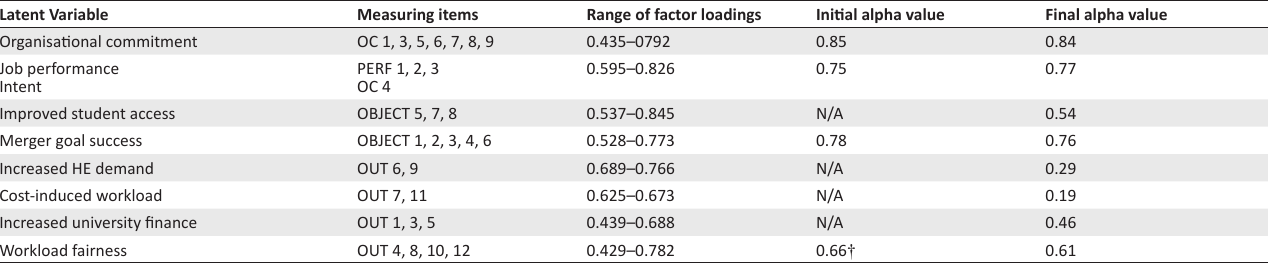
TABLE 2: Empirical factor structure after the exploratory factor